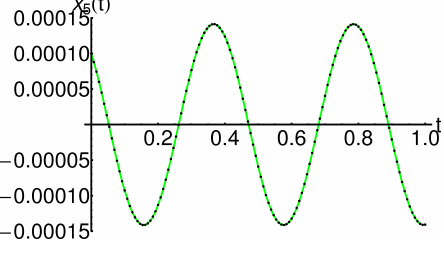
Fig. 5. Comparison between the approximate solutions ¯ x 5 given by Eq. (32) and the corresponding numerical solutions